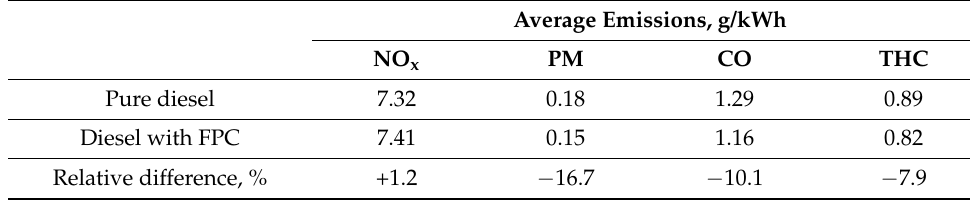
Table 7. Average emissions of exhaust gas components for various